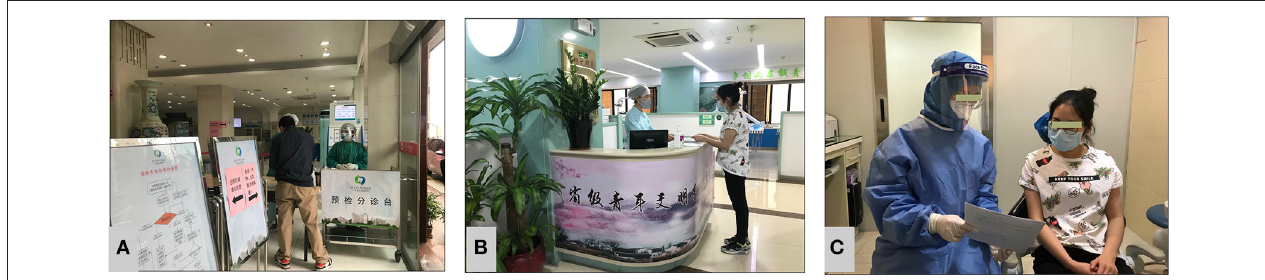
FIGURE 2 | Three-level pre-screening and triage. (A) Level 1 lobby triage. (B) Level 2 clinic front desk triage. (C) Level 3 consultation space